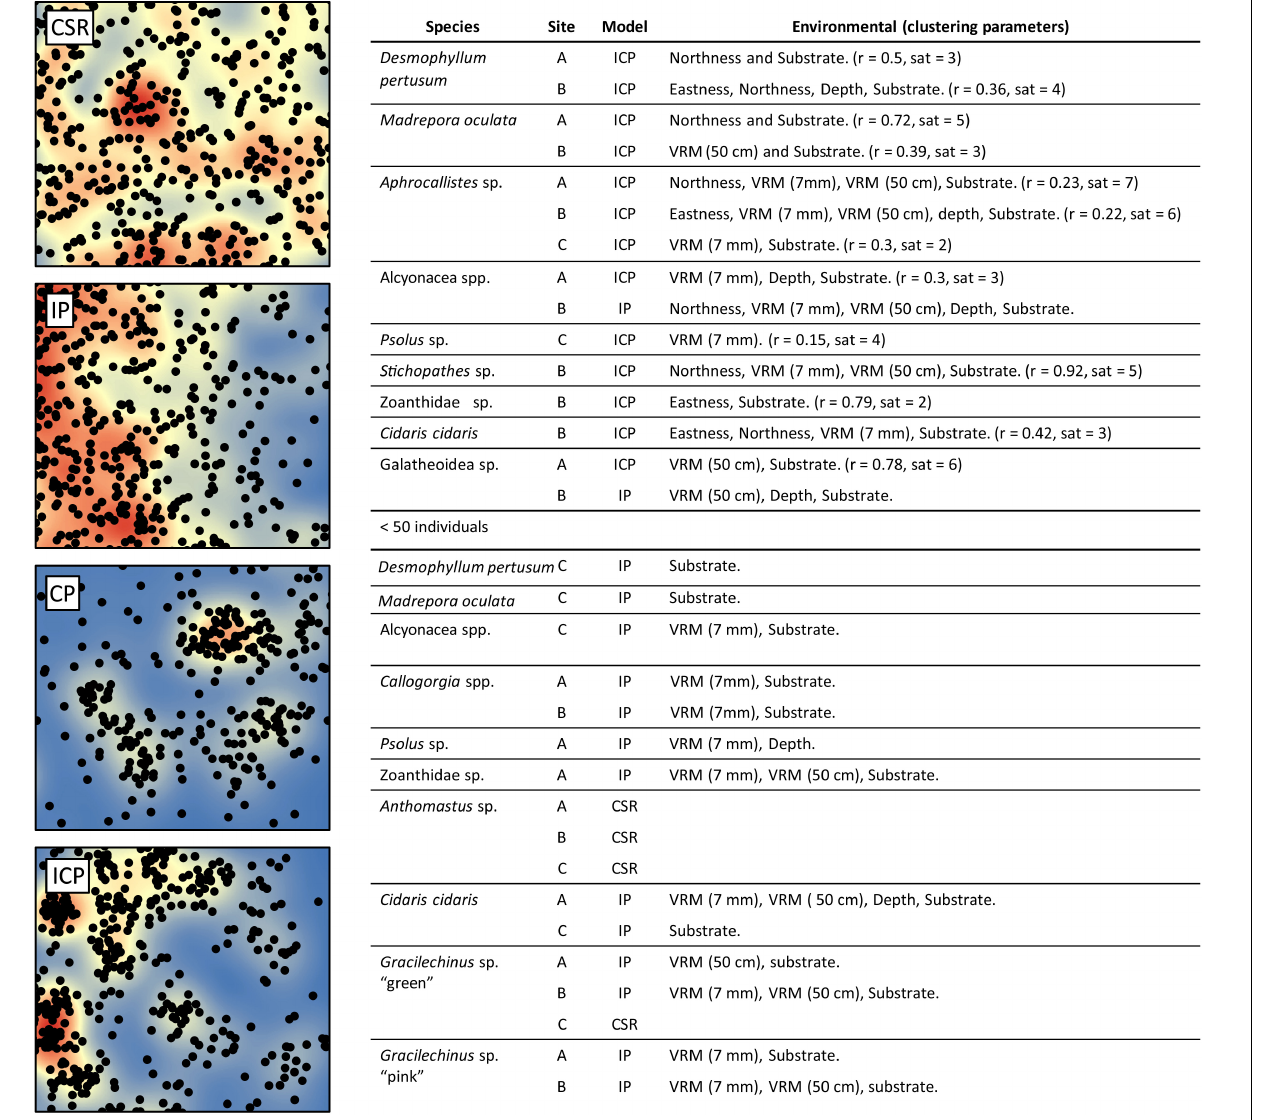
FIGURE 11 | Single theoretical simulation of Aphrocallistes sp. distribution from Site A assuming Complete spatial randomness (CSR), Inhomogeneous point pattern (IP), Clustering point pattern (CP), and Inhomogeneous clustering point pattern (ICP). Kernel density is plotted in the background. The models chosen for the 13 species based on the lowest AIC score are listed in the accompanying table with environmental and Geyer’s point interaction ( r = distance (m), sat = saturation threshold) parameters specified where